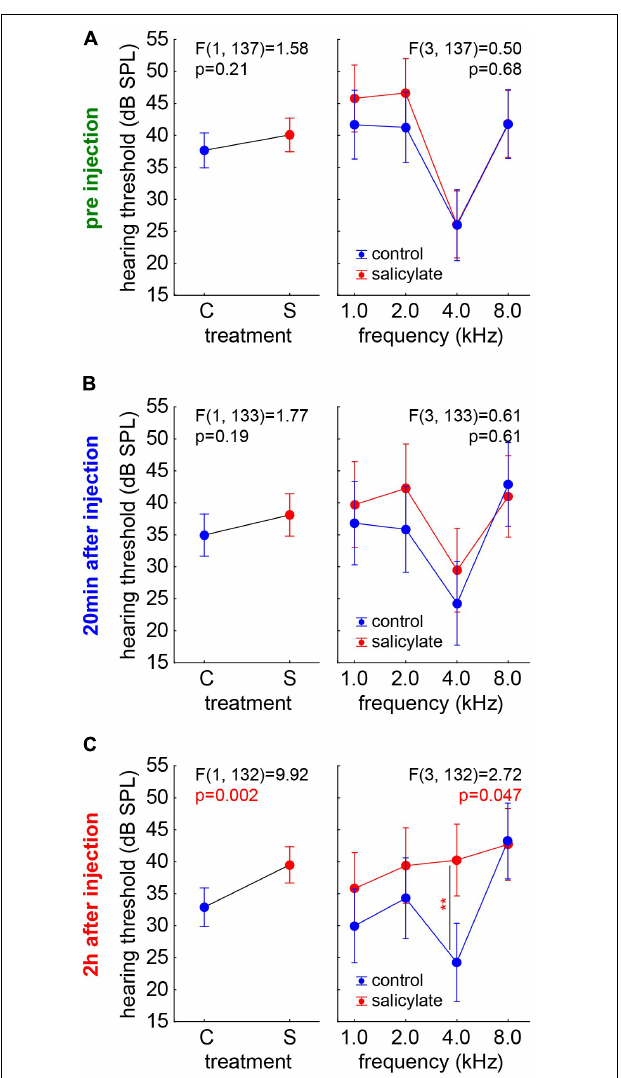
FIGURE 3 | Comparison of the HT of the salicylate and control groups over time. Results of the two-factorial ANOVAs with the factors group (left panels) and their interaction with frequency (right panels) at the three different time points. (A) Before the injection, both groups did not show significantly different HT and no significant interaction of time X frequency . (B) 20 min after injection, there is no significant different HT, and there is no significant interaction between the factors. (C) 2 h after injection, a significant higher HT in the salicylate group compared with the control animals and a significant interaction of both factors was found. At 4 kHz, the HT was affected strongest, as indicated by a significant Tukey post hoc test ( p =